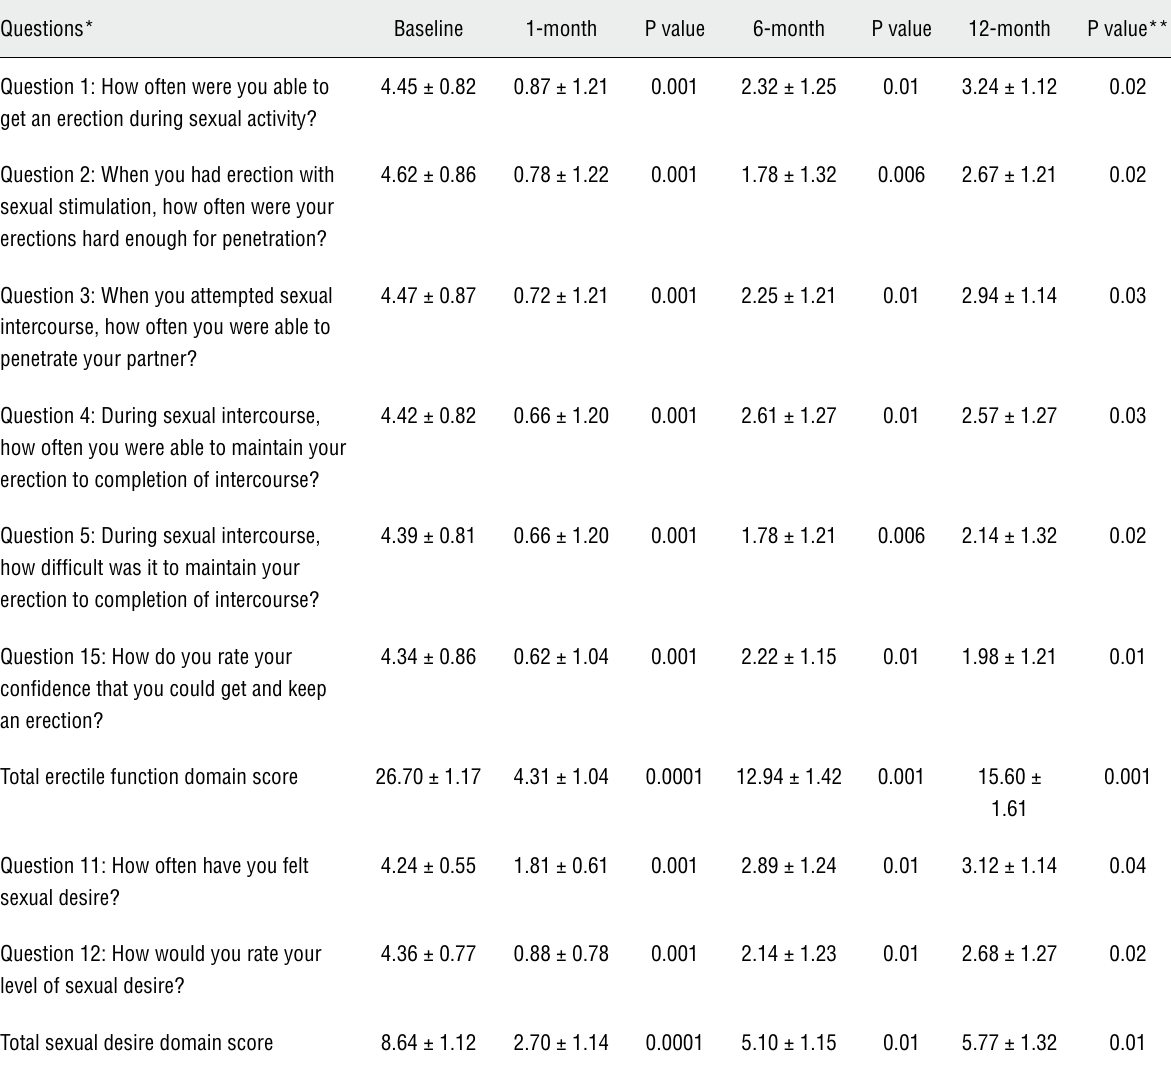
Table 3 - Erectile function and sexual desire domains at baseline and after radical cystoprostatectomy in orthotopic ileal neobladder